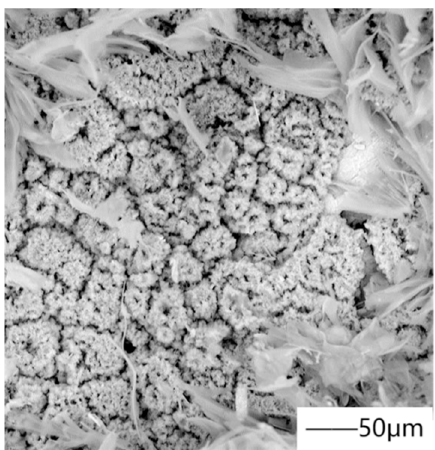
Figure 8. shows the SEM micrograph of superhydrophobic hydroxyapatite coating. Reprinted Figure 8. Shows the SEM micrograph of superhydrophobic hydroxyapatite coating. Reprinted with with permission from Ref. [67]. Copyright 2018 Copyright Elsevier. permission from Ref. [67]. Copyright 2018 Copyright